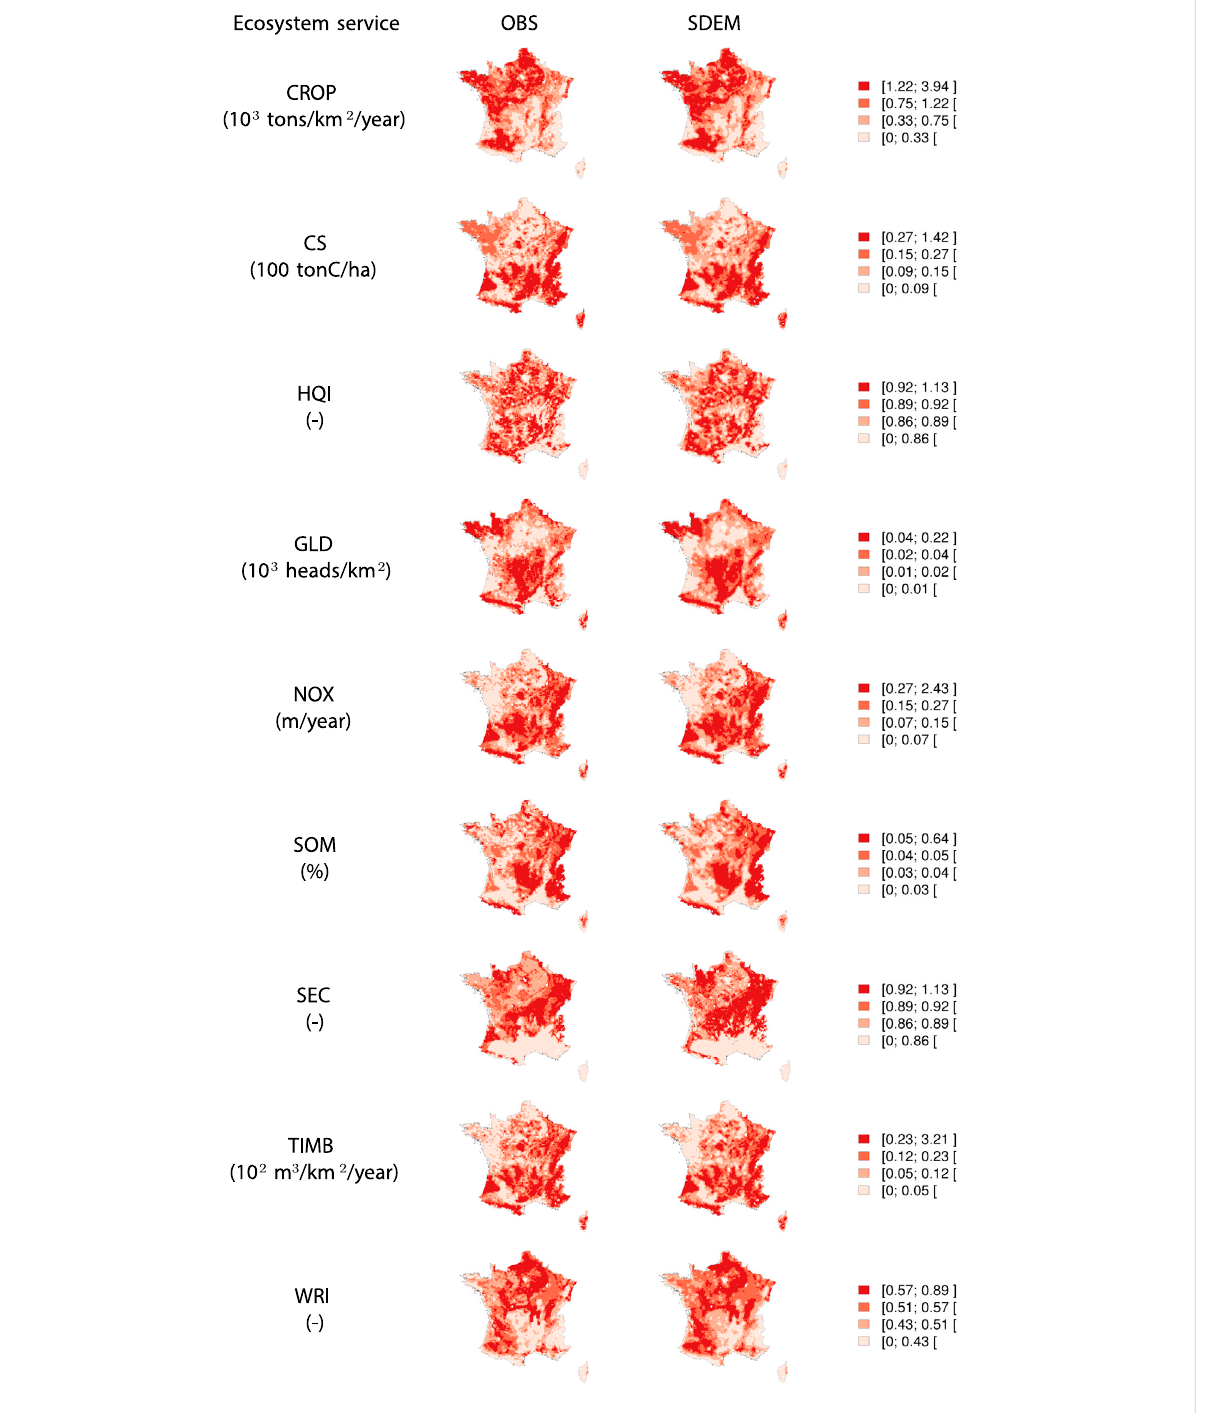
FIGURE 2 Spatial distributions of ecosystem services from observations (OBS) and from the spatial Durbin error model (SDEM). The color scale is unique foreachecosystemservice.CROPstandsforcropproduction;CSforcarbonstorage;HQIforhabitatqualityindex;GLDforgrazinglivestockdensity; NOX for deposition velocity of nitrous oxide; SOM for topsoil organic matter concentration; SEC for soil erosion control; TIMB for timber removal; WRI for water retention